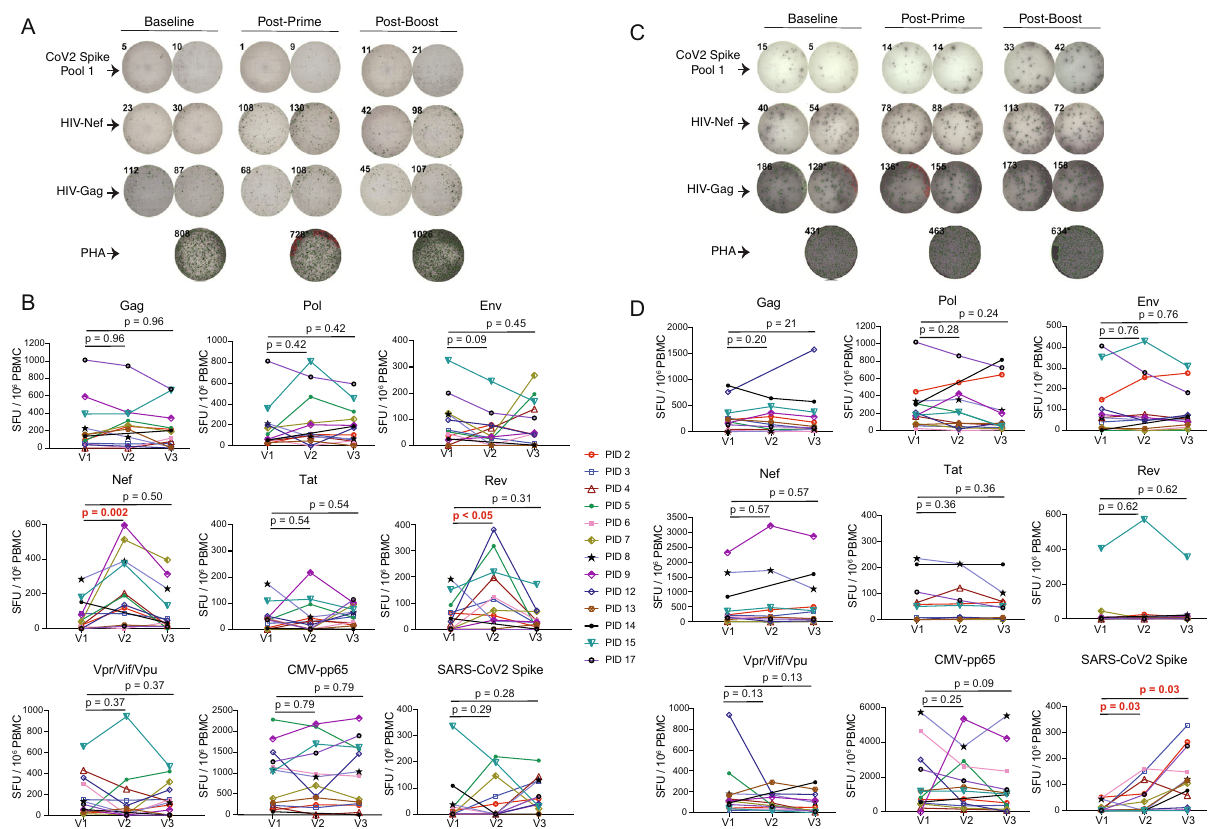
Fig. 4 | Transient increases in granzyme-B T-cell responses to early HIV- gene products following the fi rst dose of SARS-CoV-2 mRNA vaccination. A , C Representative ELISPOT results measuring granzyme-B (Gzm-B) ( A ), or IFN- γ ( C ). Peptide stimulations are plated in duplicates. B , D Combined ELISPOT results ART-treated donors at baseline (V1), and ~2 weeks after vaccine dose 1 (V2) or vaccinedose2(V3).Gzm-B – B ,IFN- γ – D n =13donorsforandV3,and n =12forV2